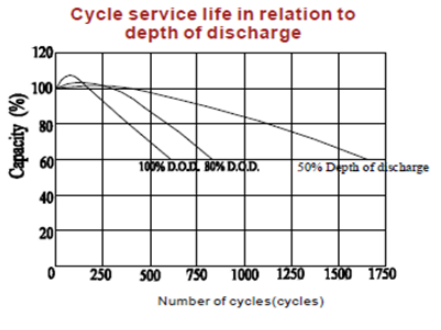
Figure 20. CG2 800 cell cycling capacity and the DoD [92].